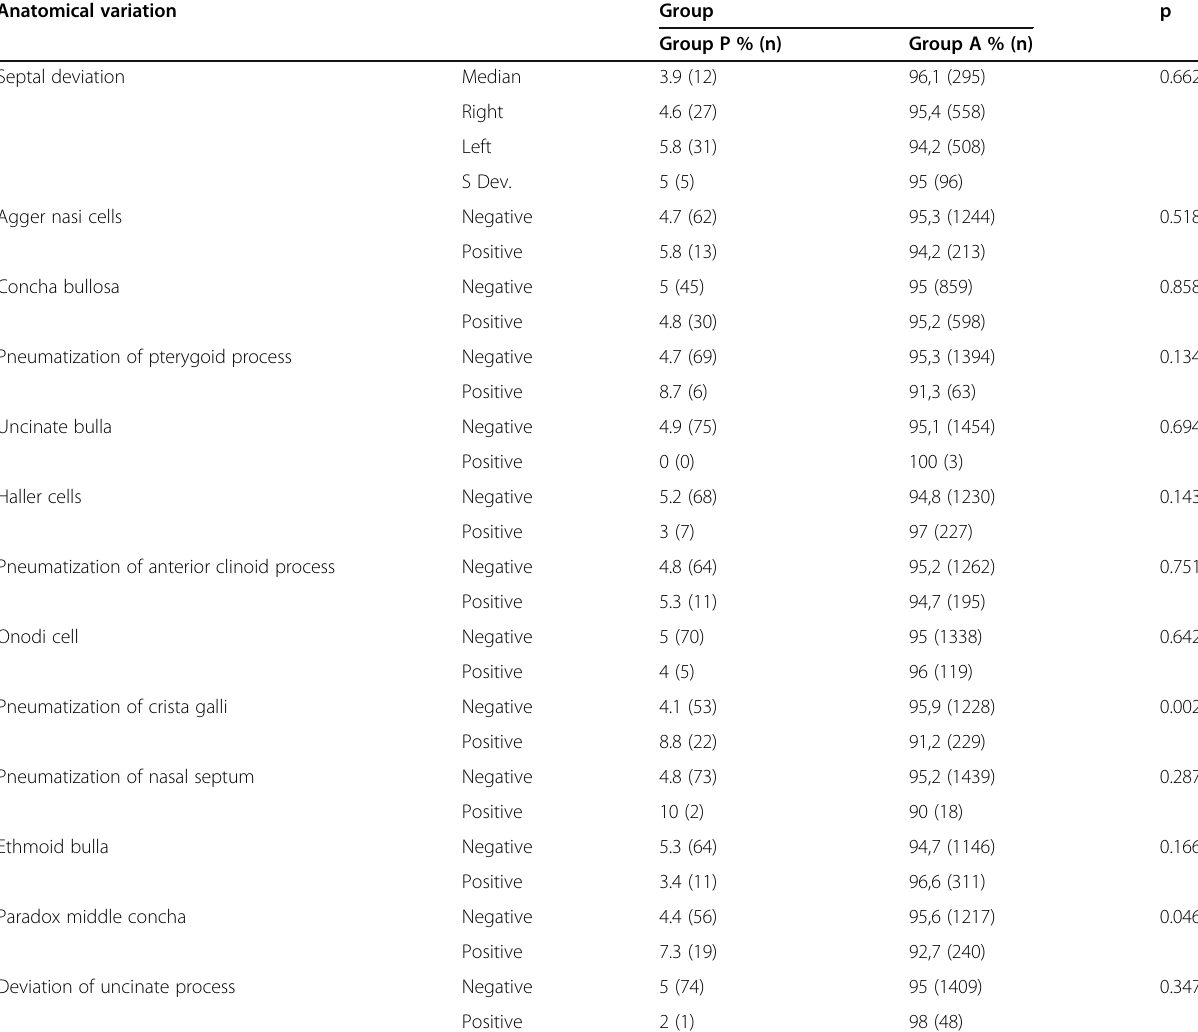
Table 2 Distribution of anatomical variations in pediatric and adult age groups Anatomical